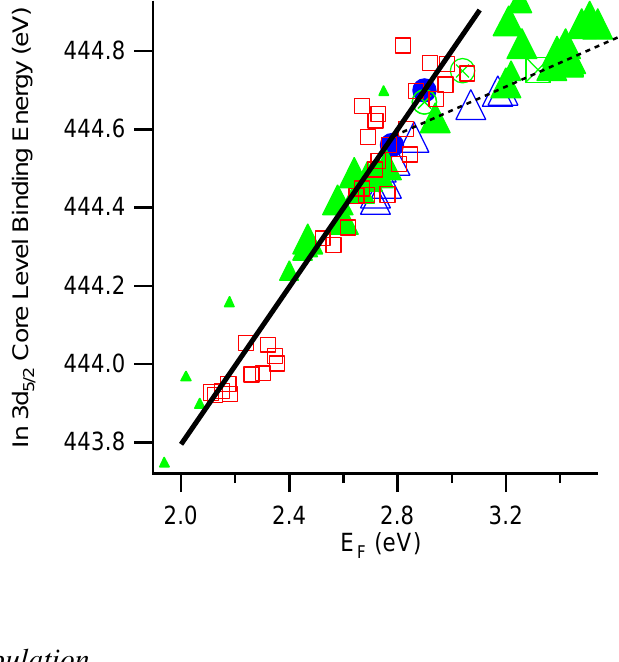
Figure 3. In 3d5/2 core level binding energy vs. Fermi level position for In solid line marks a slope of one. Squares represent In solid circles represent sintered ceramic ITO, solid triangles represent 10% doped ITO films, open triangles represent 2% doped ITO films, cross circles represent air-annealed ITO films (at 400 ◦ C), and crossed squares represent ozone treated ITO films. Symbol size reflects the substrate temperature during deposition, which ranges from room temperature (small) to 400 ◦ C